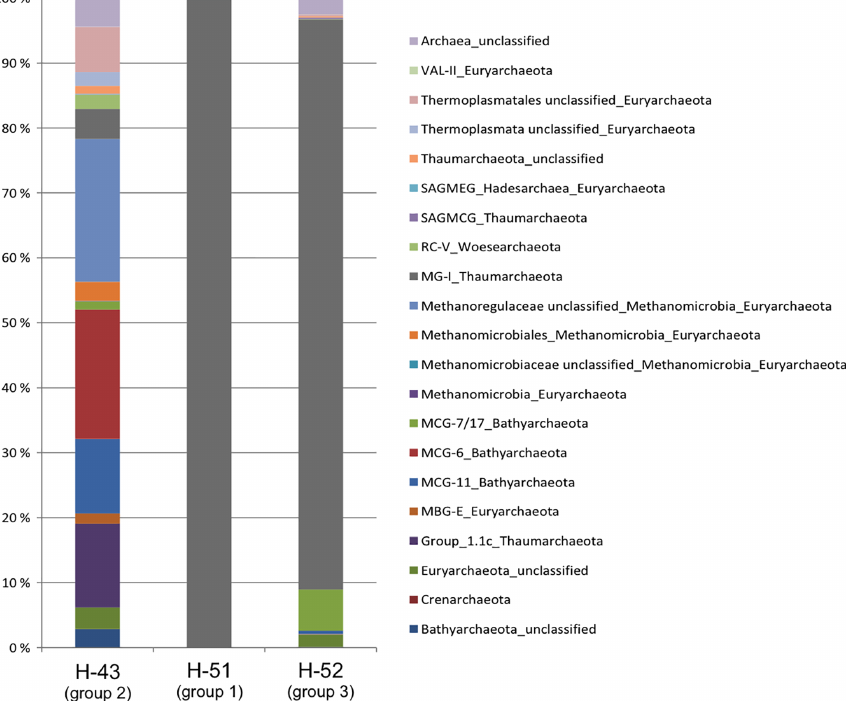
Figure 5. Phylogenetic affiliations of DNA-based archaeal 16S rRNA gene reads in percent of total reads, for groundwater samples of all wells for time point May 2015. Table 3. Mass fluxes derived from the NETPATH model. The unit of all displayed mass transfers ismmolL − 1 . Negative leading signs indicate that the respective phase is removed from the water phase. “Exchange” refers to cation exchange and numbers in brackets in the “calcite” column refer to isotopic exchange between DIC and calcite minerals. CH 2 O refers to organic